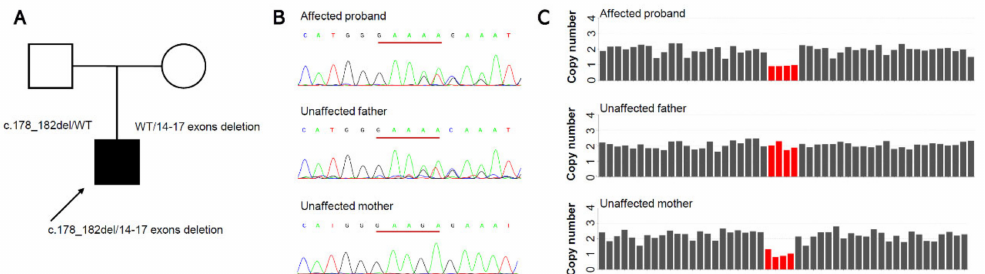
Figure 2. Molecular finding of the Chinese Han families. ( A ) The boy was born to non- consanguineous unaffected parents. ( B ) The sanger sequence of the family members showing a novel heterozygous c.178_182del variant in the affected proband and his unaffected father. ( C ) Chro- mosome 2q21.3 deletion removing 4 of the 24 exons of RAB3GAP1 in the affected proband and his unaffected mother identified from whole exome sequencing